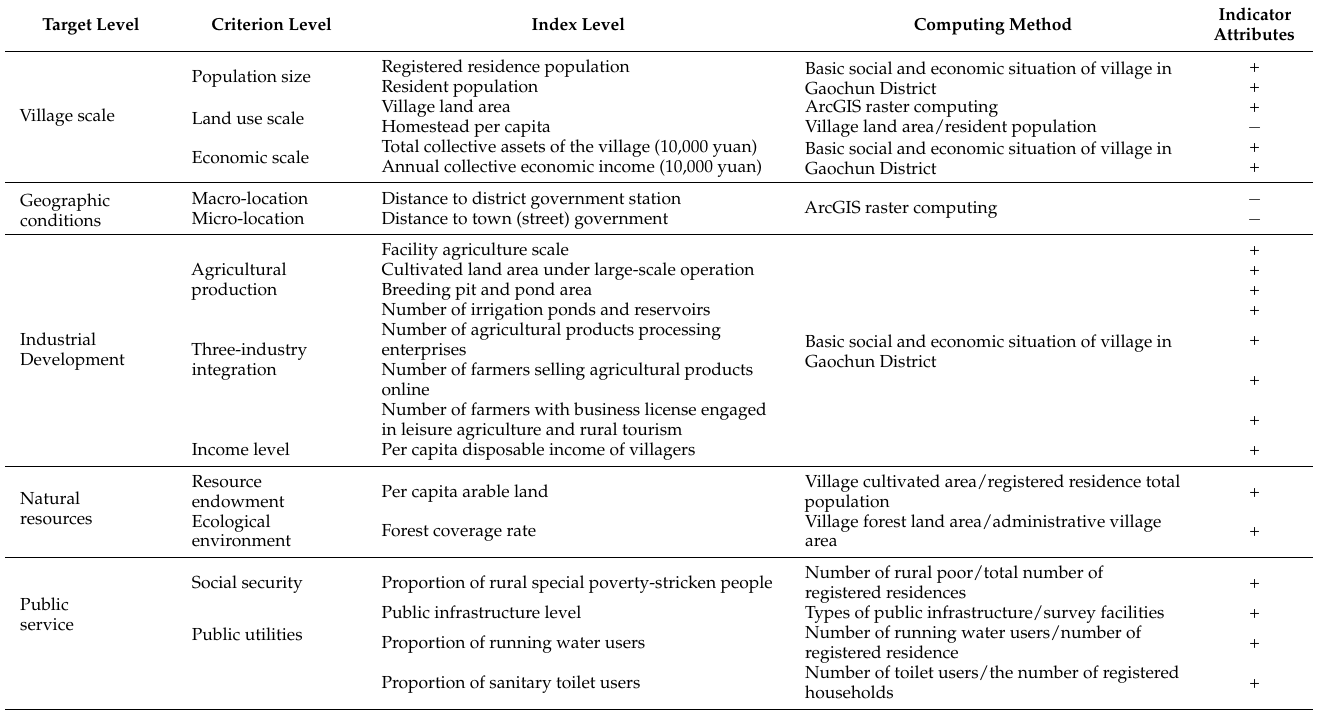
Table 1. The village development level index